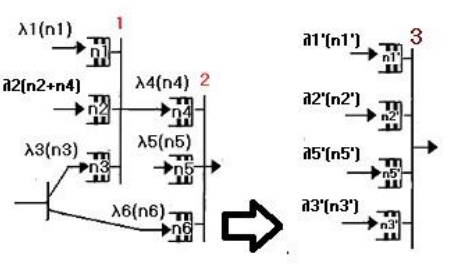
Figure 7. Coupling of synchronization